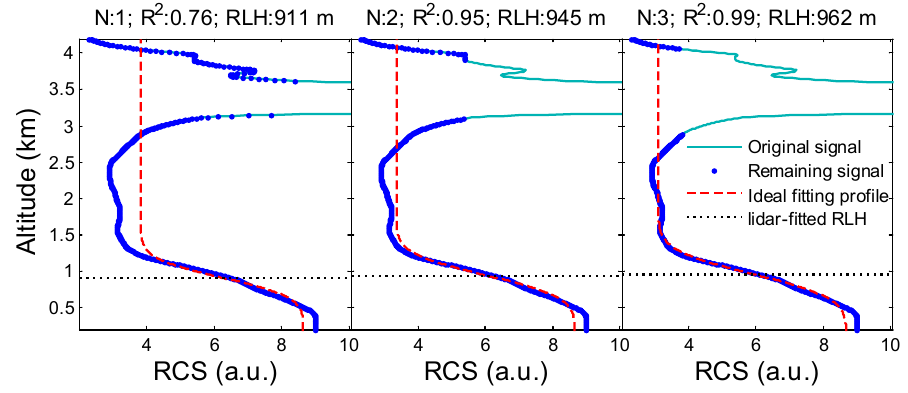
Figure 6. RLHs determined by the improved method with Lidar-measured RCS at 23:28, 12 May 2015 (CST). The signal corresponds to the black dotted line in Figure 4.